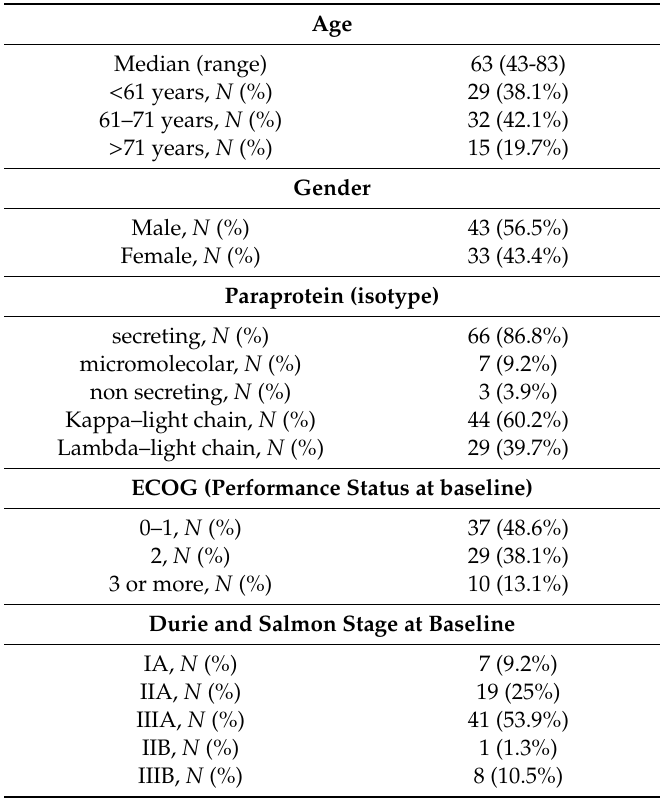
Table 2. Patients’ clinical characteristics (Cytogenetic high risk was defined as the presence of, t (4; 14), t (14; 16), or del17p documented by